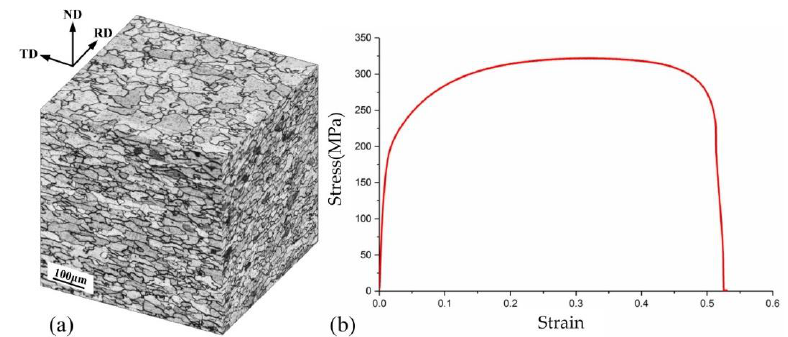
Figure 4. ( a ) The 3D microstructure and ( b ) stress and strain curve of the DC04 steel.